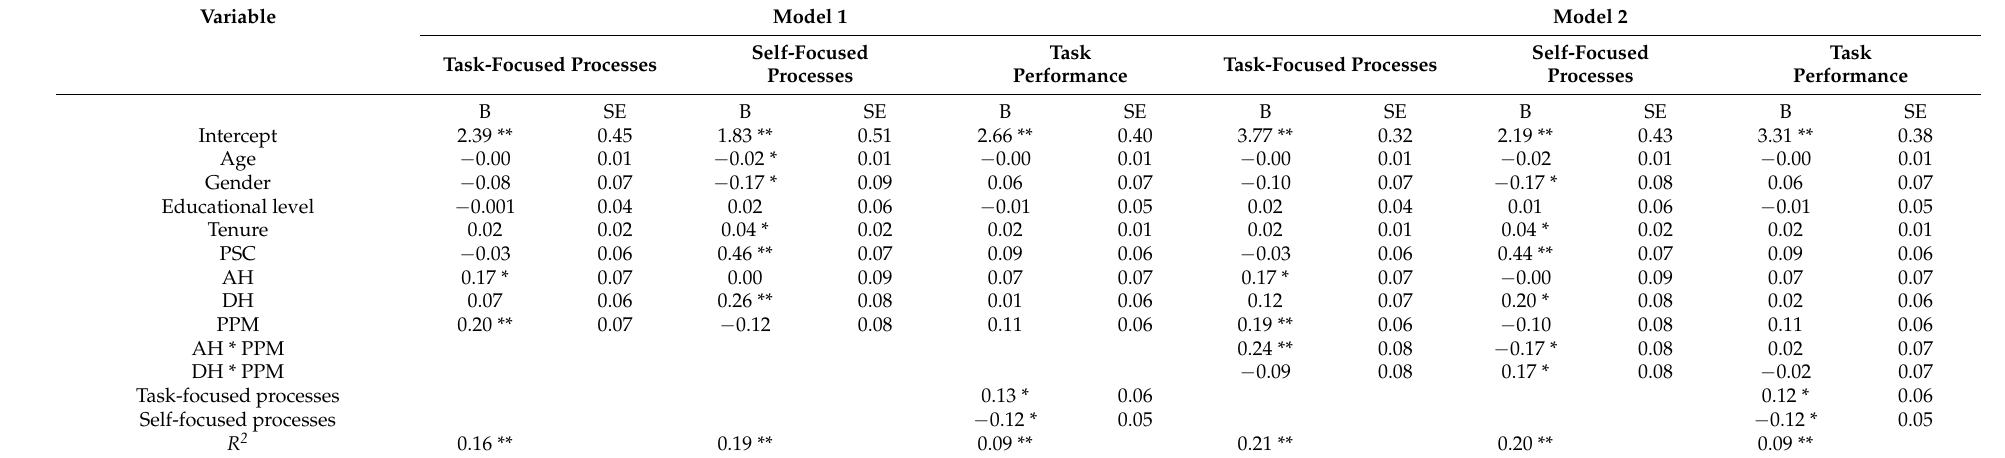
Table 3. Hypotheses Testing